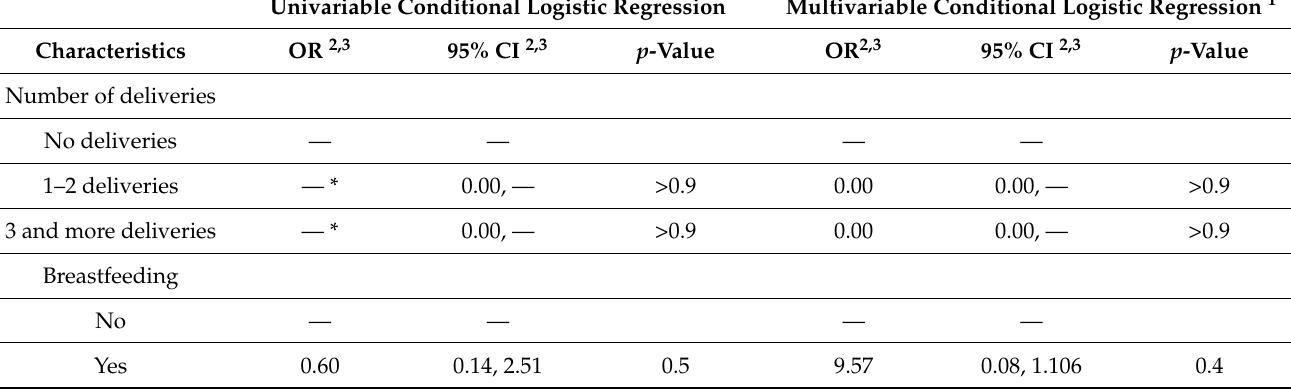
Table 3. Cont. Univariable Conditional Logistic Regression Multivariable Conditional Logistic Regression 1